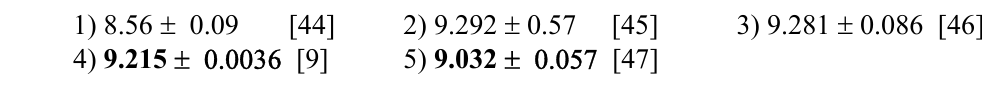
) [kcal/mol] based on data of e